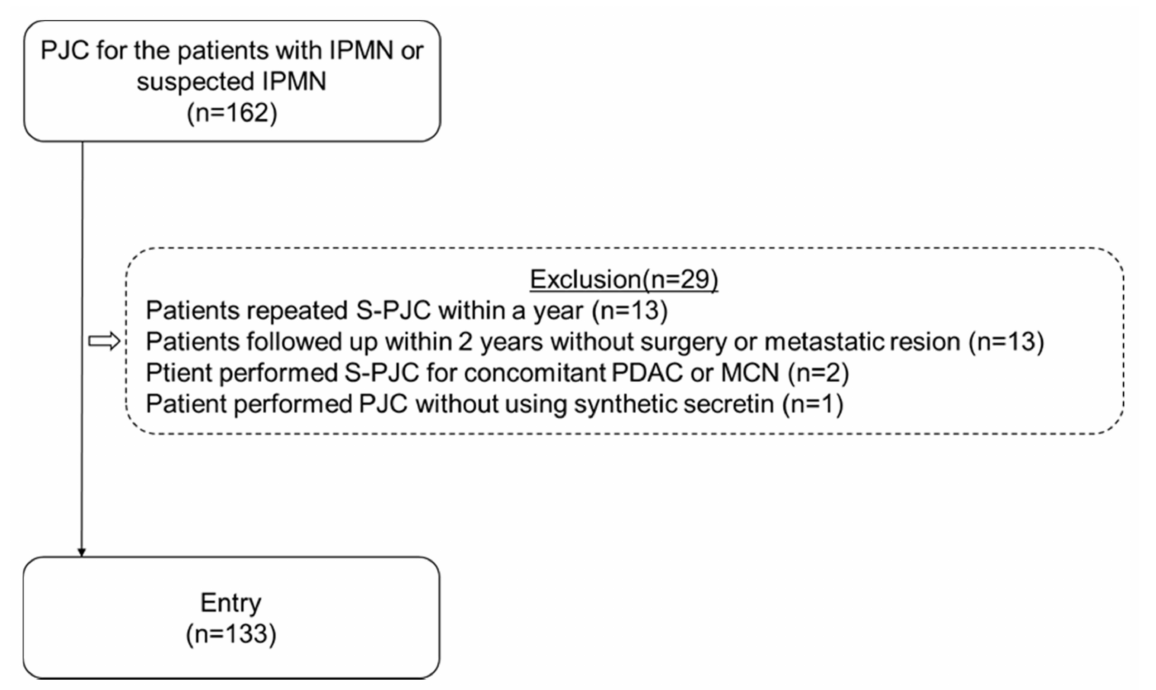
Figure 1. The algorithm used for patients’ inclusion and exclusion in this study. A total of 162 patients with IPMN or suspected IPMN were included. After excluding 29 patients (due to repeated S-PJC within a year, follow-up within 2 years without surgery or metastatic lesion, concomitant pancreatic ductal adenocarcinoma or mucinous cyst neoplasm, and the use of PJC without synthetic secretin), the remaining 133 patients were enrolled in this study. S-PJC: secretin-loaded pancreatic juice cytology; PJC: pancreatic juice cytology; PDAC: pancreatic ductal adenocarcinoma; MCN: mucinous cystic neoplasm; IPMN: intraductal papillary mucinous